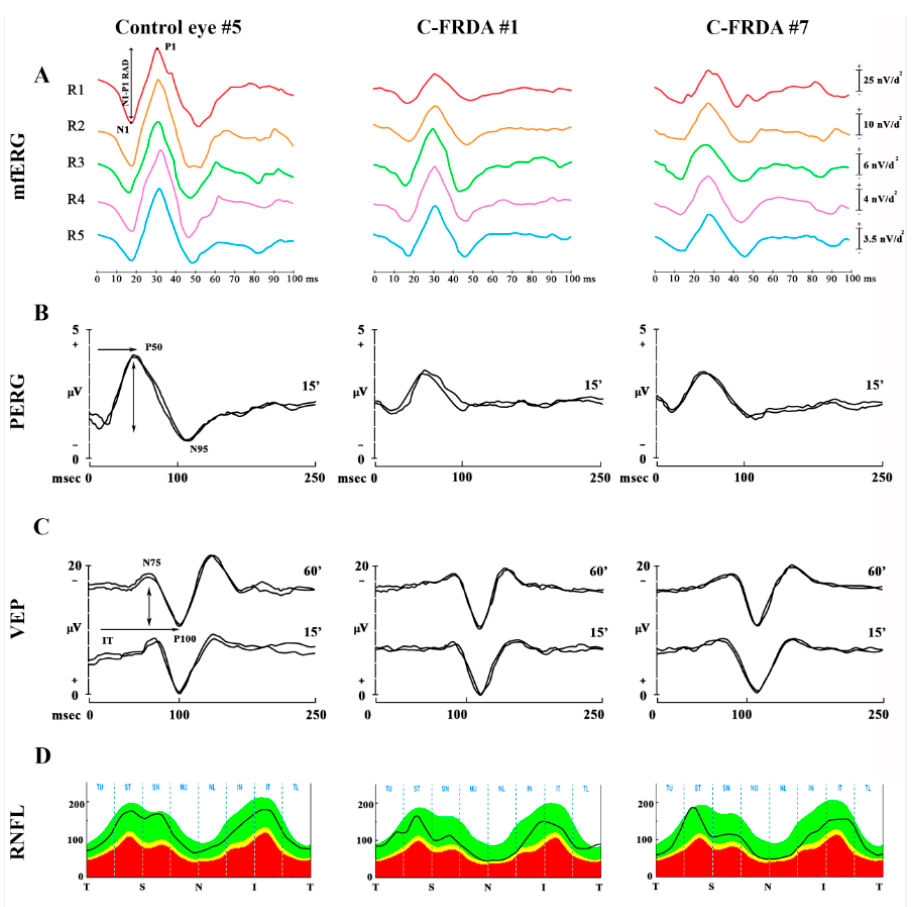
Figure 1. Examples of Multifocal Electroretinogram (mfERG) recordings ( A ), Pattern Electroretino- gram (PERG) ( B ), Visual Evoked Potentials (VEP) ( C ), and Optical Coherence Tomography (OCT) Retinal Nerve Fiber Layer (RNFL) thickness ( D ) from the eyes of one representative control subject and two subject carriers for Friedreich’s ataxia (C-FRDA). ( A ) The mfERG Control eye traces the N1-P1 ( ↕ ) response amplitude density (RAD, measured in nanoVolt/degree 2 —nV/deg 2 ); it is obtained from five concentric annular retinal regions (rings) centered on the fovea: from 0 to 2.5 degrees (ring 1, R1, in red), from 2.5 to 5 degrees (ring 2, R2, in orange), from 5 to 10 degrees (ring 3, R3, in green), from 10 to 15 degrees (ring 4, R4, in purple), and from 15 to 20 degrees (ring 5, R5, in blue). The RAD values are reduced in all rings in C-FRDA eyes with respect to the Control eyes. ( B ) In the PERG examples, 15 ′ refers to checked edges subtending 15 min (15 ′ ) of the visual angle for pattern reversal visual stimuli; P50 and N95 refer to the first positive and the second negative peak, whose P50 implicit time (IT, → ) and P50-N95 peak-to-peak amplitude (A, ↕ ) were considered. A reduced 15 ′ PERG A and a delayed 15 ′ PERG IT are found in the C-FRDA eyes respect to the Control eyes. ( C ) In VEP examples, 60 ′ and 15 ′ refer to checked edges subtending 60 min (60 ′ ) and 15 min (15 ′ ) of the visual angle for pattern reversal visual stimuli, respectively; N75 and P100 refer to the first negative and the first positive peaks of VEP recordings, whose P100 IT ( → ) and N75-P100 peak-to-peak A ( ↕ ) were considered. 15 ′ VEP IT and 60 ′ VEP IT are delayed in C-FRDA eyes with respect to Control eyes. ( D ) In the OCT RNFL analysis, T refers to the temporal sector, S refers to the superior sector, N refers to the nasal sector, and I refers to the inferior sector. The average of the values detected in each sector is considered. The RNFL thickness values in the nasal sector are reduced in C-FRDA eyes with respect to the Control eyes.